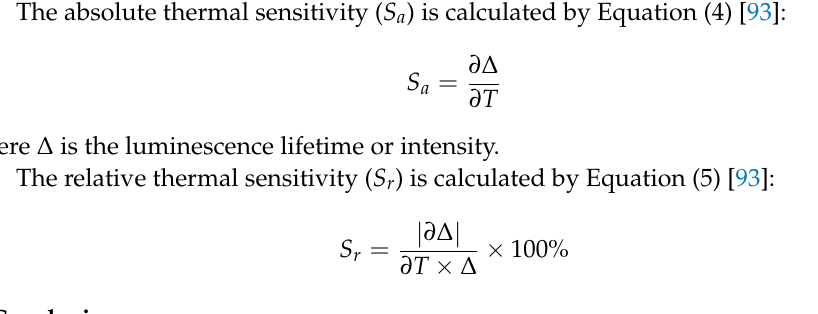
Figure S2. 3D structure of the Eu(III) complex;. Figure S3: Absorption spectra of PLA composite films doped with different content of the Eu(III) complex; Figure S4: Absorption spectra of the ligands and synthesized complexes dissolved in hexane; Figure S5: Concentration dependence of the absorption spectra of PLA composite films doped with different content of the Eu(III)